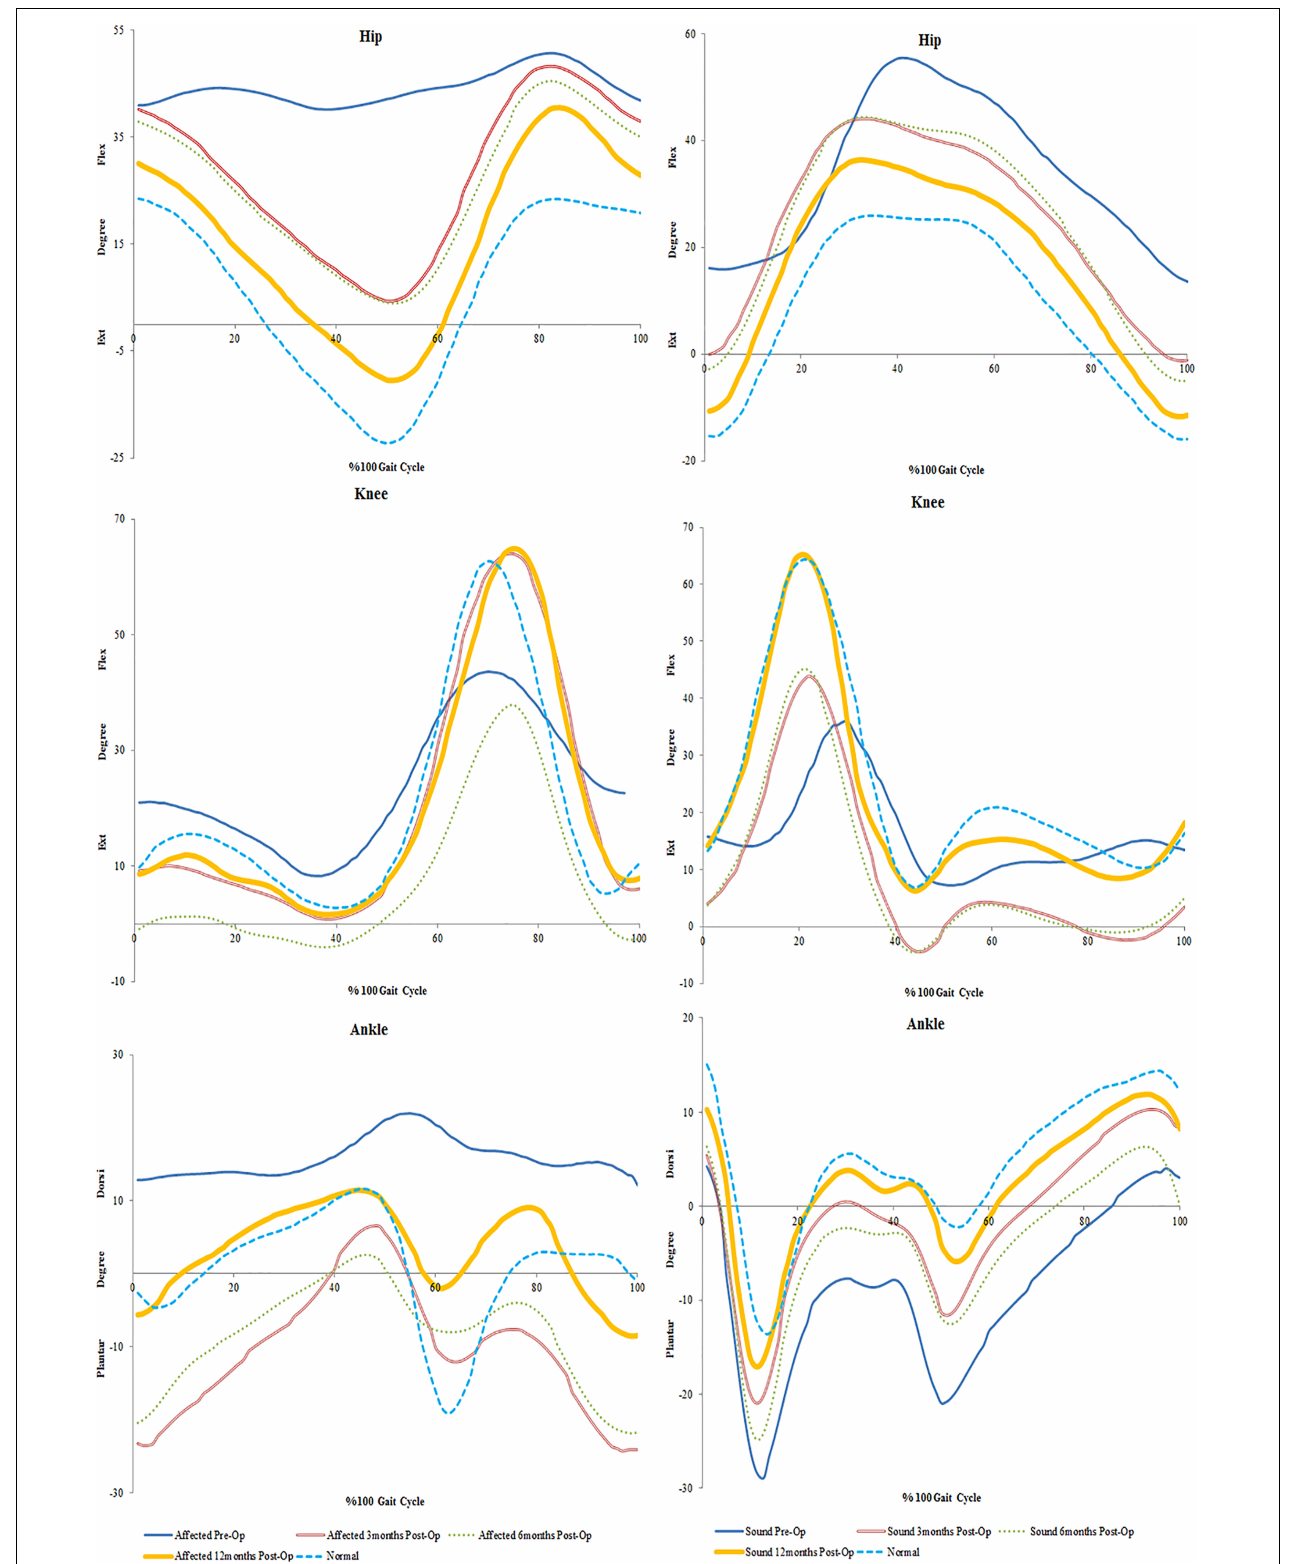
FIGURE 2 | Mean trends of knee flexion-extension in the affected and sound side during gait cycle in spastic patient 1.